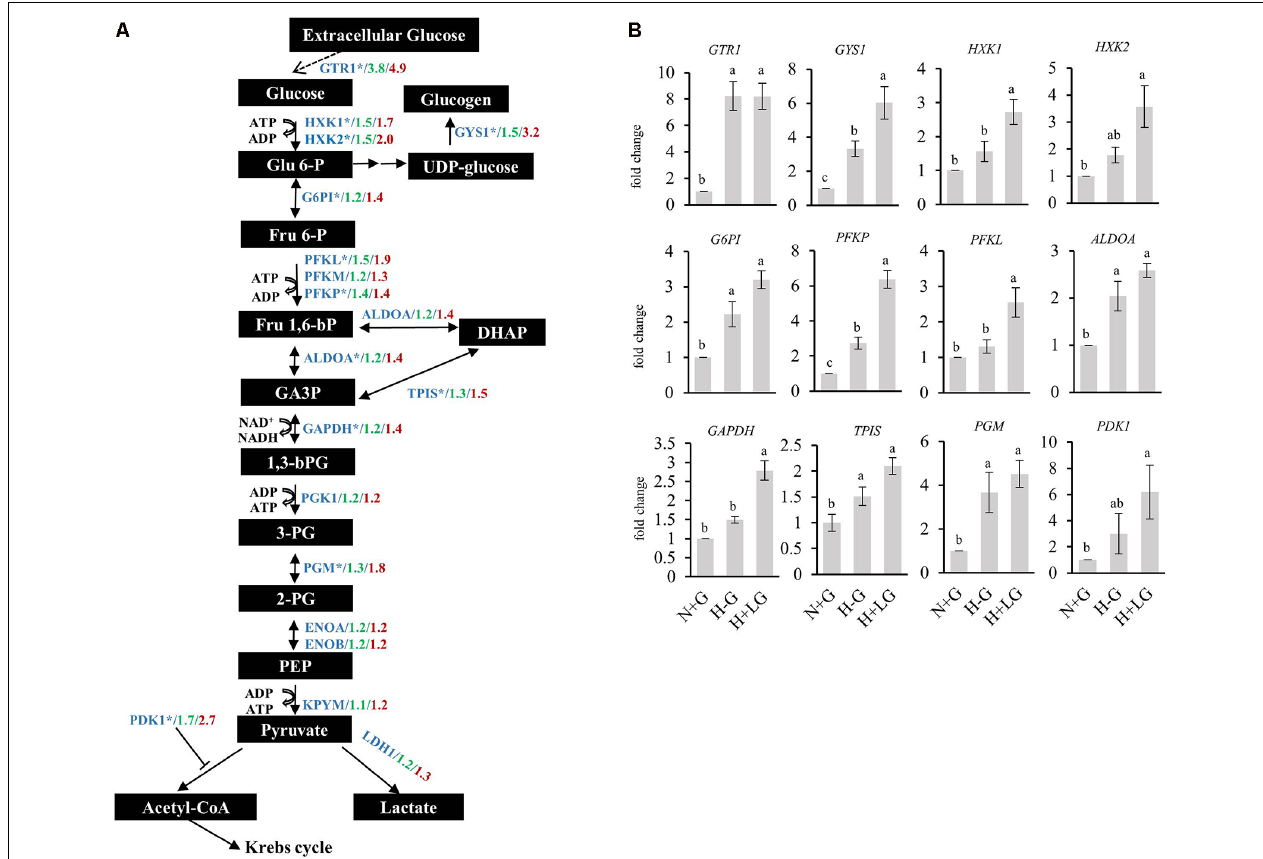
FIGURE 10 | Expressions of proteins and genes involved in glucose metabolism under N+G, H − G, and H+LG treatments. (A) A schematic diagram of the glucose metabolic pathway was adapted from Hamanaka and Chandel (2012) and Leiherer et al. (2014). All metabolites were labeled in black boxes, while proteins were marked in blue. The levels of fold changes between H − G and N+G from the quantitative proteomic analysis were in green, while those between H+LG and N+G were in red. (B) The results of qRT-PCR of selected genes from the glucose metabolic pathway marked by an asterisk in (A) , which was based on abundance change between H+LG and N+G treatments ≥ 1.4-fold. Fold changes were calculated by comparing to N+G after being normalized with β -actin and set as 1. All data plotted are the average of five independent experiments ± SD. One-way ANOVA followed by Fisher’s least significant difference for multiple comparisons was used for statistical analysis. Different letters labeled represent significant differences at p < 0.05 level among